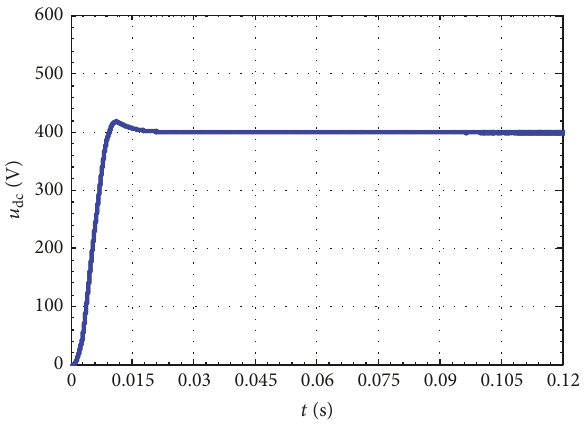
Figure 5: Waveform of DC bus voltage.